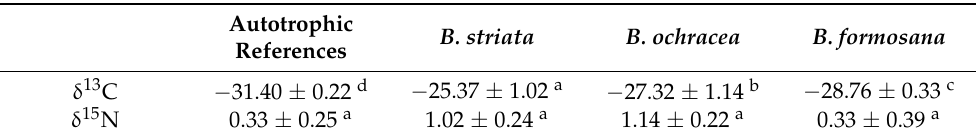
Figure 6. Overview of δ 13 C and δ 15 N values of stem, leaf, flower, and root tissues from Bletilla , and leaf tissue from autotrophic reference plants (ref) in this study. ( a ) represents B. striata ; ( b ) represents B. ochracea ; ( c ) represents B. formosana . Table 2. Comparison of mean δ 13 C and δ 15 N values among the autotrophic reference plants and three Bletilla species ( p < 0.05).